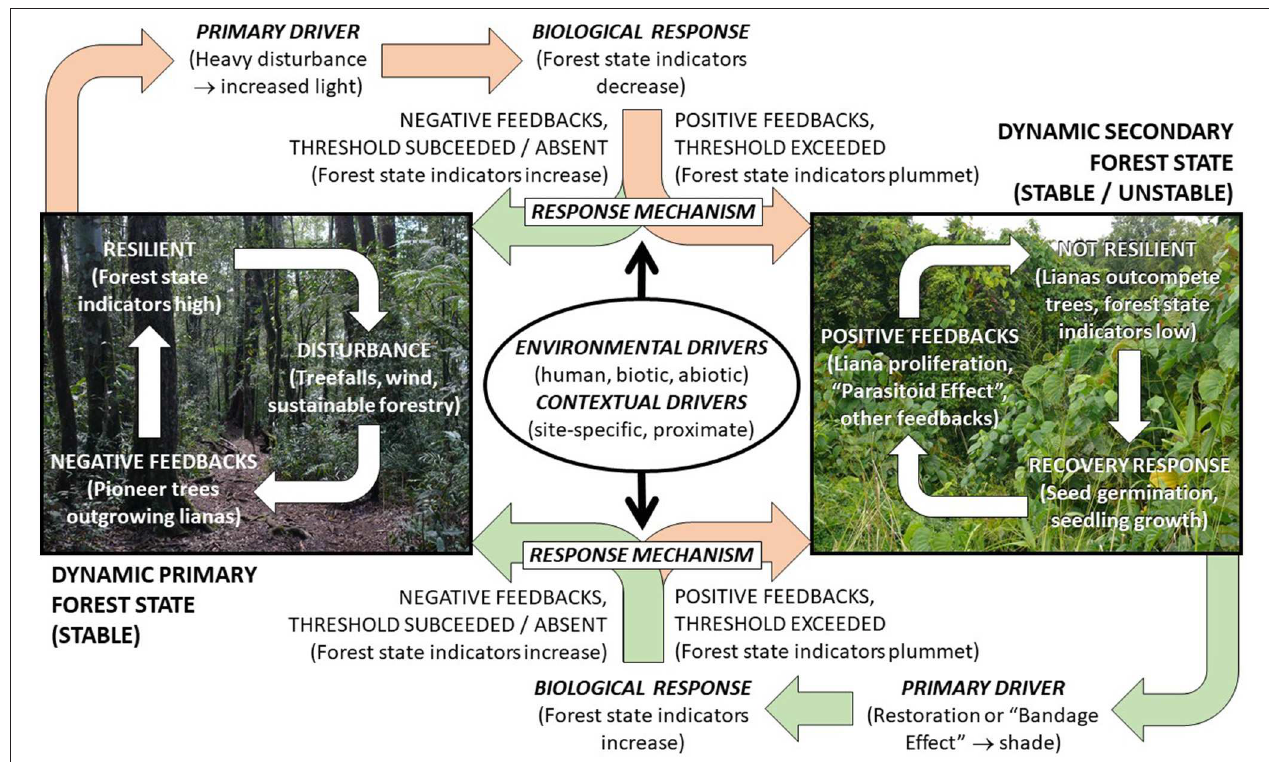
FIGURE 6 | Three data elements for identifying and describing ecological thresholds in forests (drivers, response mechanisms, and biological response; bold italic type), are expected to form a dynamic causal loop system, maintained by liana feedbacks, under scenarios of pervasive forest decline (peach arrows), recovery (green arrows), and stasis (white